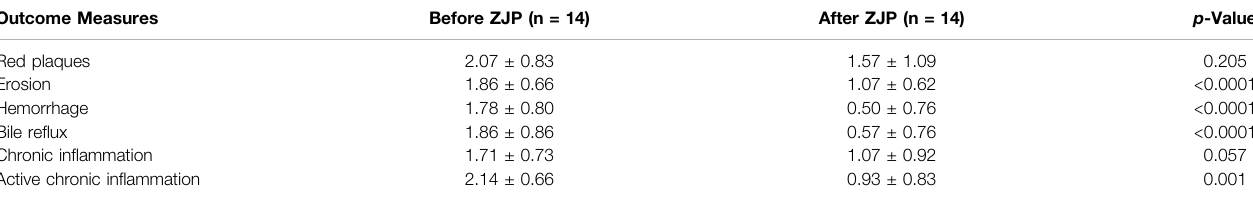
TABLE 1 | Comparison of endoscopy and histology evaluation before or after Zuojin pill (ZJP) treatment. Outcome Measures